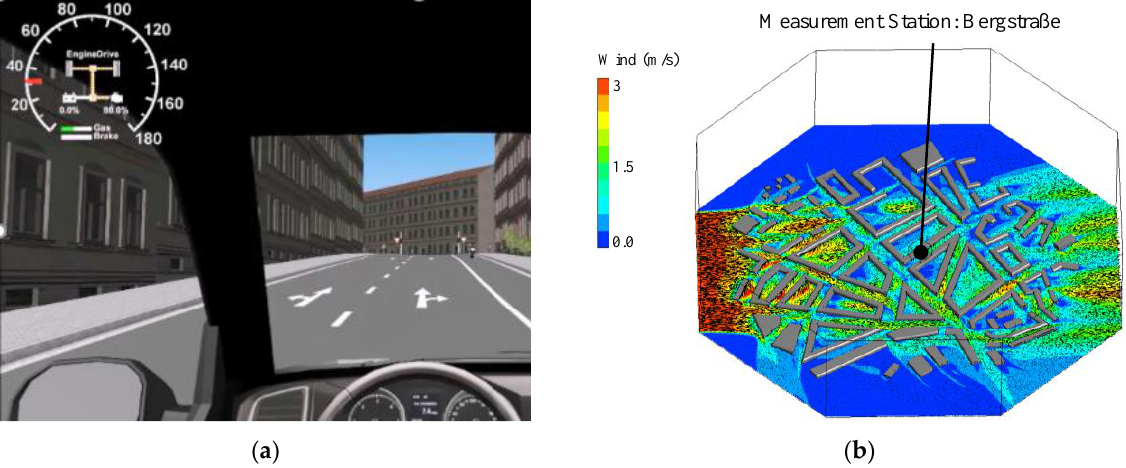
Figure 3. Simulation environment (Erfurt, Germany): ( a ) vehicle simulation model ( b ) CFD model (global wind direction: west/global wind speed 10 km/h).